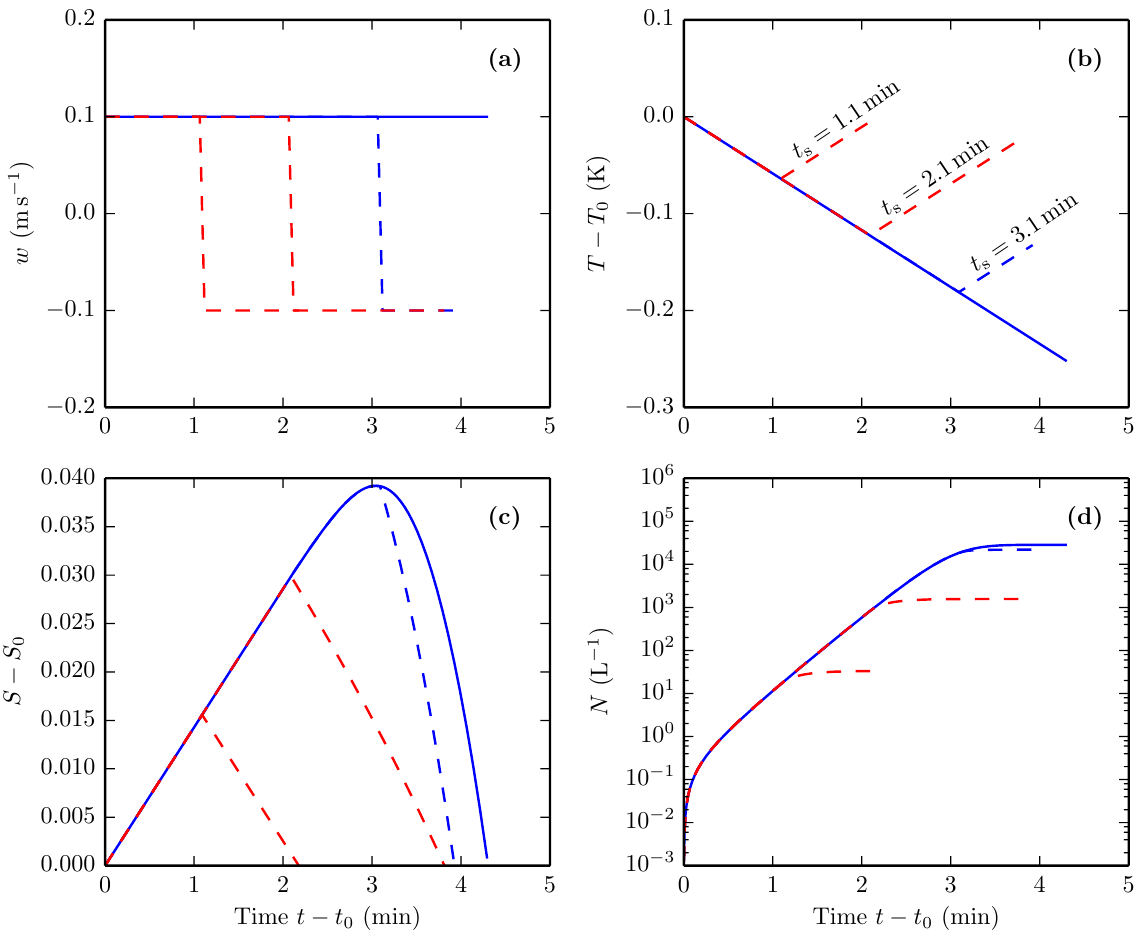
Figure 5. Evolution of vertical velocity (a) , temperature (b) , saturation ratio (c) , and INC (d) during nucleation events forced by constant w = 0 . 1ms − 1 (solid) and by w = ± 0 . 1ms − 1 (dash) as defined by Eq. (7). Blue curves show vapour-limit events and red curves show temperature-limit